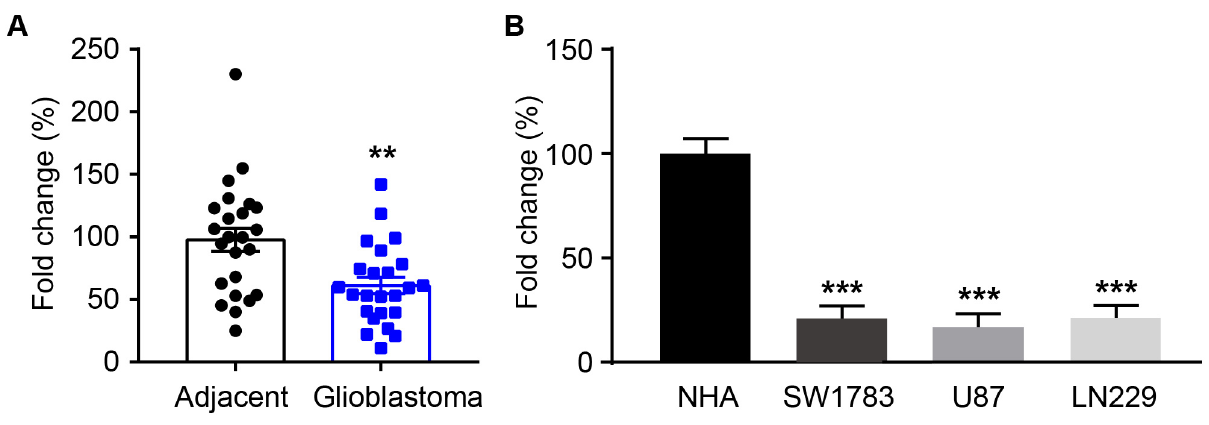
Fig. 2. Decreased miR-325-3p expression in glioma tissue and cell lines. (A) Results from RT-qPCR analysis showed that miR-325-3p was decreased in human glioma tissues. (B) Decreased miR-325-3p levels were also detected in glioma cells. Data are presented as the mean ± SEM, ** p < 0.01, *** p < 0.001, compared to the corresponding control group.